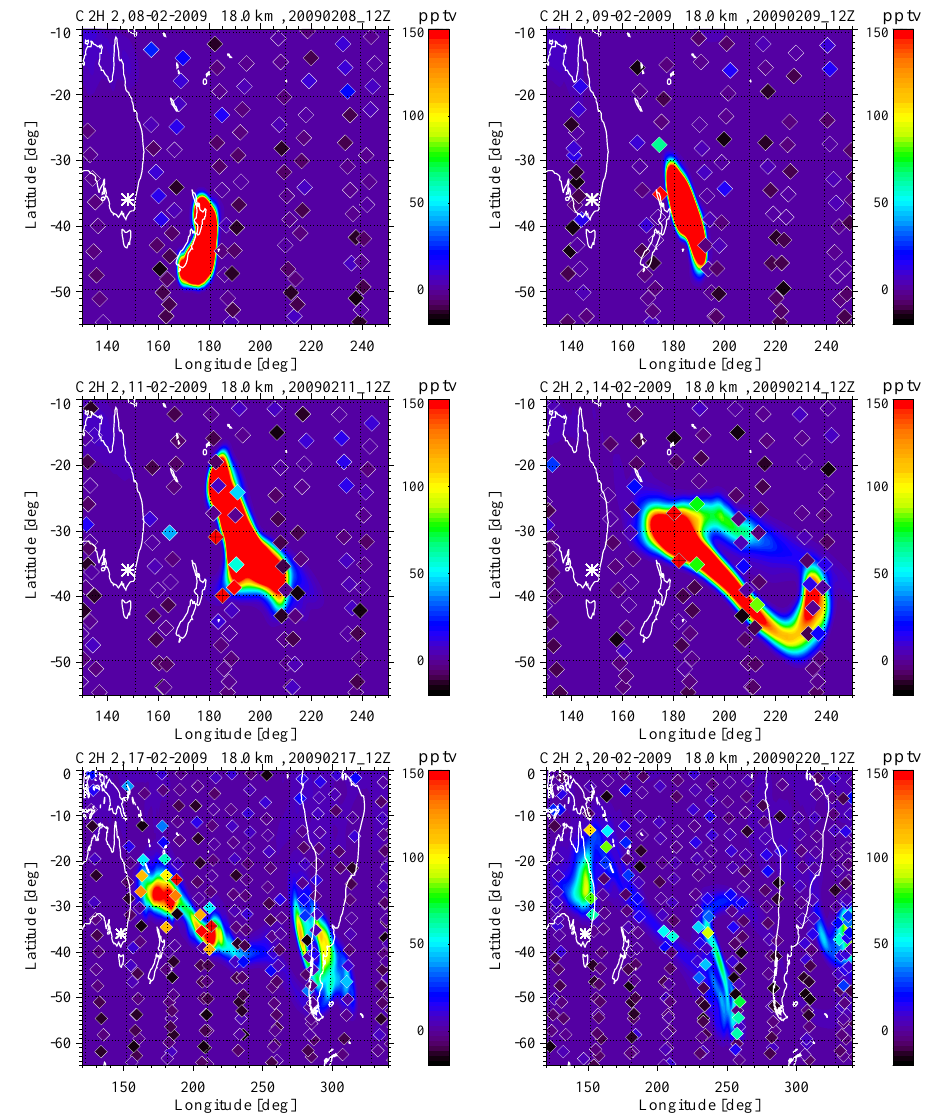
Fig. 6. Measured and modelled C 2 H 2 at 18km altitude. Model distributions are smoothed vertically and along-track to MIPAS resolution. Note the different map section for the bottom panel. For more details see Fig.